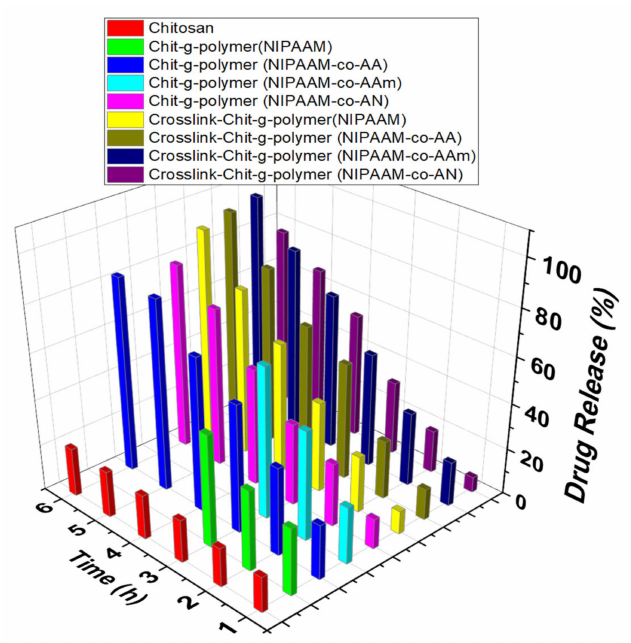
Figure 10. Drug Release performance of Grafted Copolymers and Crosslinked-graft Copolymers of NIPAAM and Binary Comonomers onto Chitosan. Polymeric taster = 25.00 mg, Concentration of DS solution for the drug-laden = 100.00 µ g/mL, amount of buffer solution = 10.00 mL, pH of the solution =